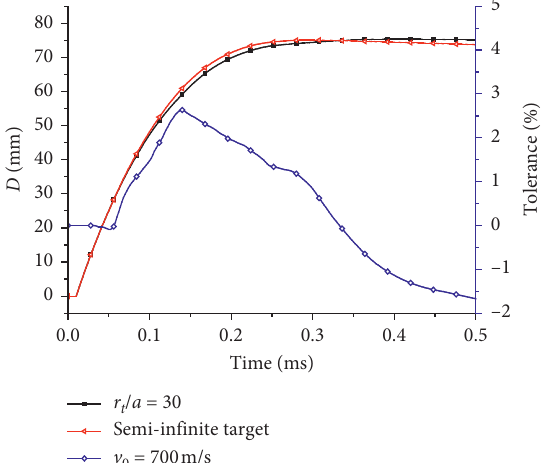
Figure 24: Deviation comparison of the penetration depth for the free boundary ( r t / a � 30) and the nonreflecting boundary ( v �